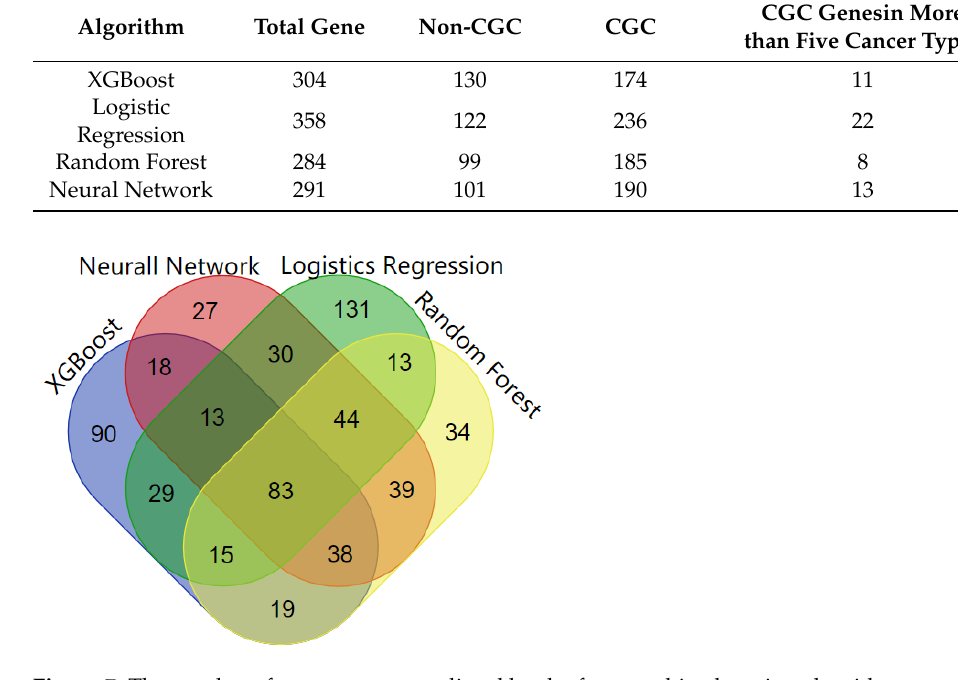
Figure 7. The overlap of cancer genes predicted by the four machine learning algorithms. Table 2. Number of driver genes detected by the four algorithms.